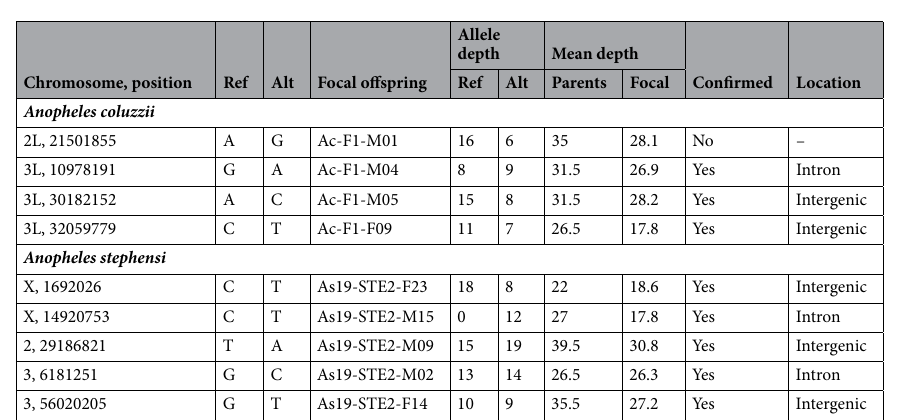
Table 4. Candidate de novo mutations detected in A. coluzzii and A. stephensi by whole genome sequencing and validated by Sanger re-sequencing. Genomic position, reference (Ref.) and alternate (Alt.) alleles in focal offspring and allele depth. Read depth mean for parents and focal offspring. All candidates were re-sequenced by Sanger sequencing for validation.